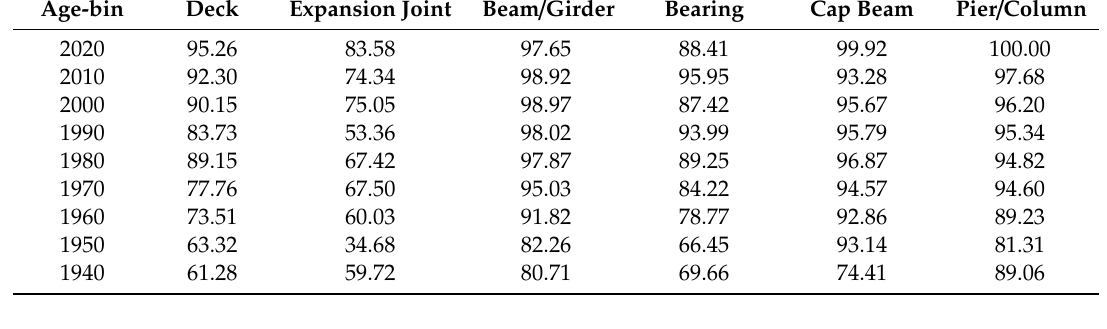
Table 4. Element health indexes by age for bridges in the ‘SO107’ group.